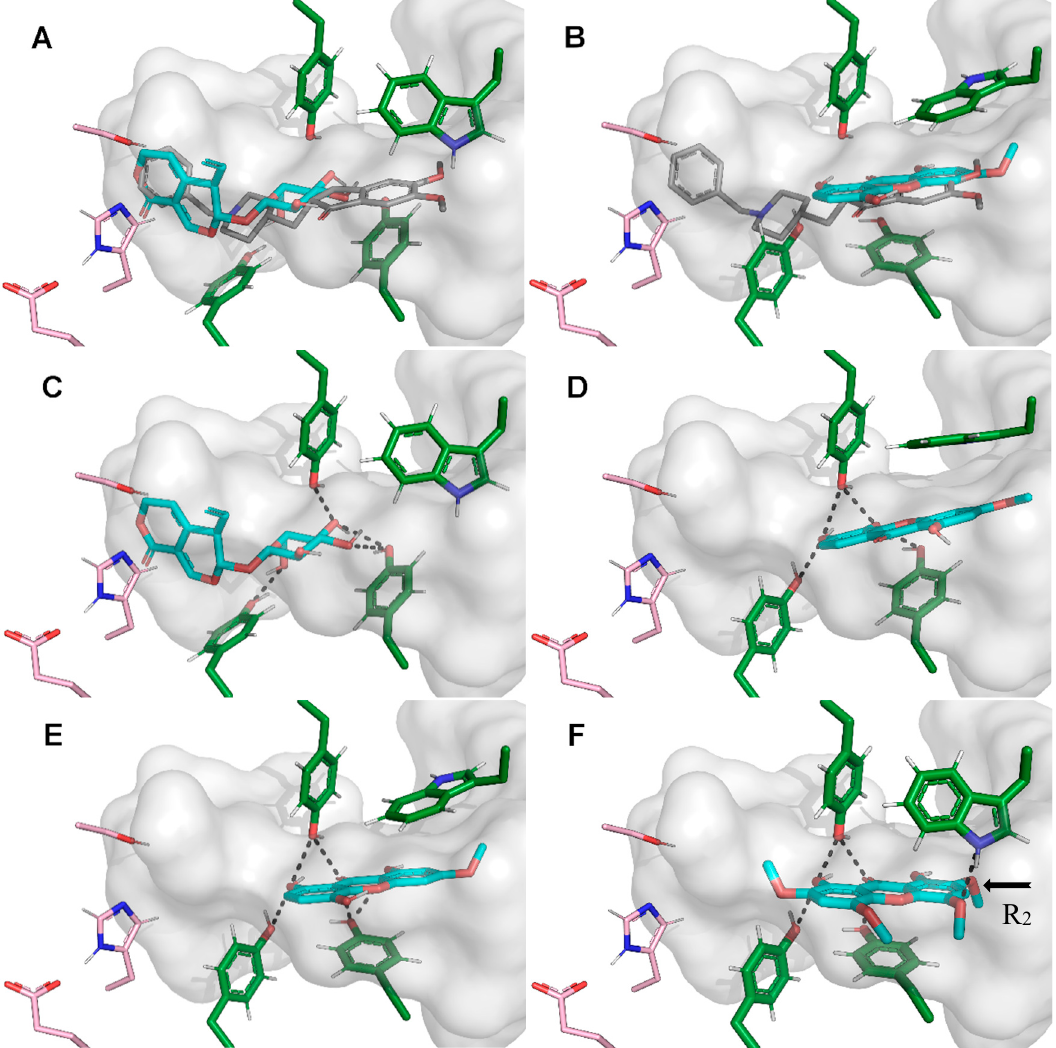
Figure 4. The lowest energy solutions from the docking calculations of gentiopicroside and the most active xanthones (cyan) in human AChE (green) are presented. Gentiopicroside ( A ) and xanthone 04 ( B ) are presented along with the X-ray structure of donepezil (PDB ID: 4EY7; [47]; dark grey) for a direct comparison. The interaction maps (black dashed lines) of gentiopicroside ( C ) and xanthones ( D —xan03, E —xan04, F —xan09) in their best poses are also shown. The most active xanthone (xan09.1) differs from xan09 by removal of a methoxy group in the position R 2 (highlighted with a black arrow— F ). The catalytic residues of AChE are indicated with pink carbons. The active site pocket was calculated with hollow software [48] and represented as a gray surface.